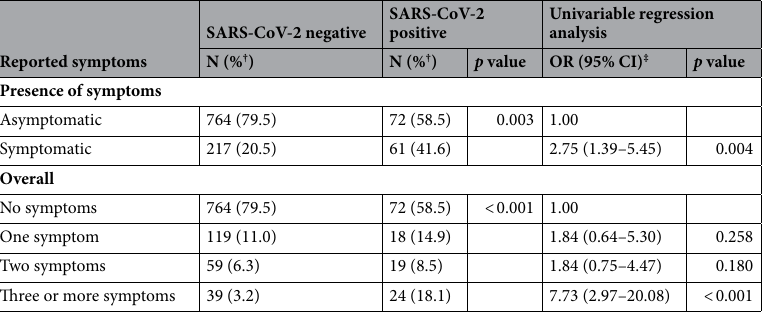
Table 3. Comparison of individuals who tested PCR negative versus individuals who tested PCR positive for SARS-CoV-2 infection* in the community survey conducted on May 6–7, 2020 with respect to presence of symptoms. CI confidence interval, OR odds ratio, PCR polymerase chain reaction. *Only 1,114 samples with information on symptoms and confirmed results were analyzed. † Column percentages weighted by age and nationality. ‡ Estimates are weighted by age and